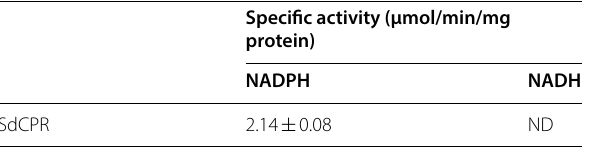
Specific activity of SdCPR in reducing cytochrome c (100 μM), in the presence of 100 μM of NADPH or NADH (n